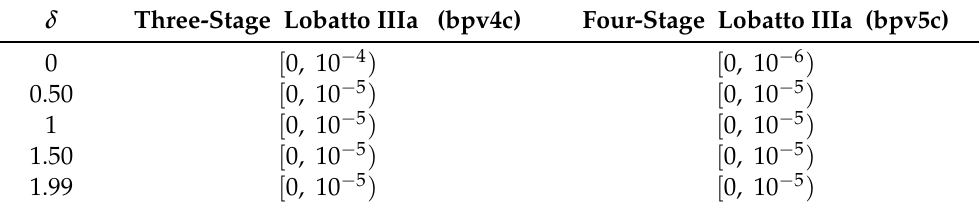
Table 4. Ranges of θλ 2 in conditions of non-convergence (Three-/Four-Stage Lobatto IIIa).